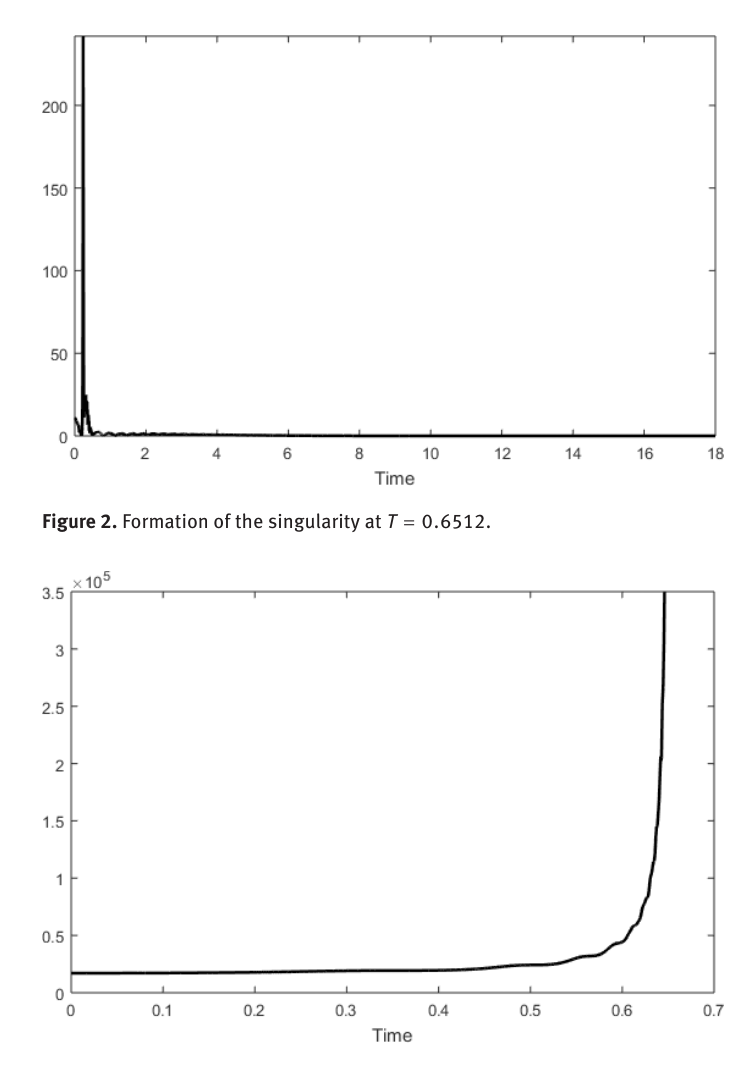
Figure 3. Variation of ‖ v r ‖ 2